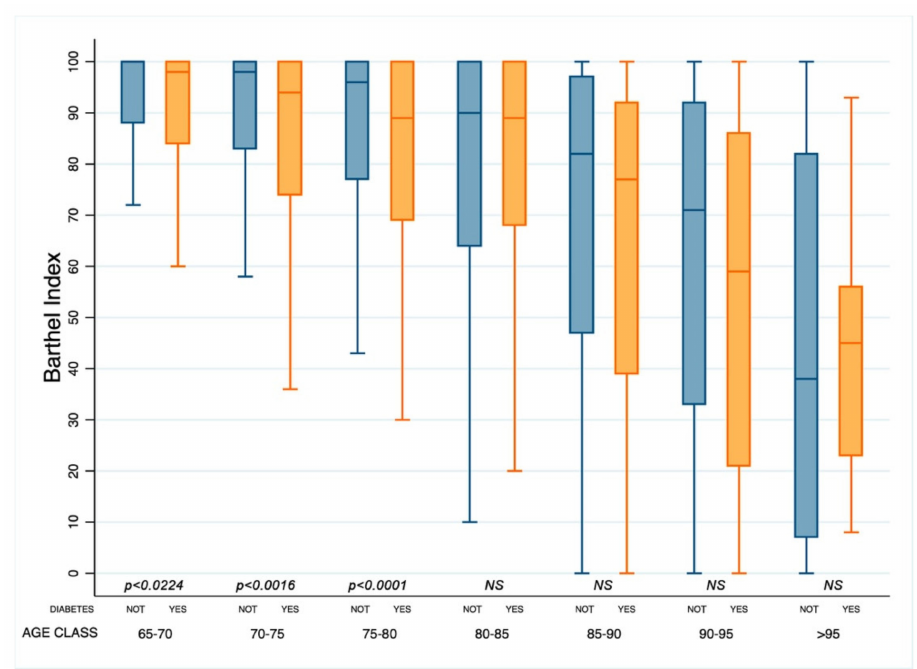
Figure 3. Box and whisker plot of the Barthel index according to age classes in patients with or without diabetes (Yes or Not). NS: not